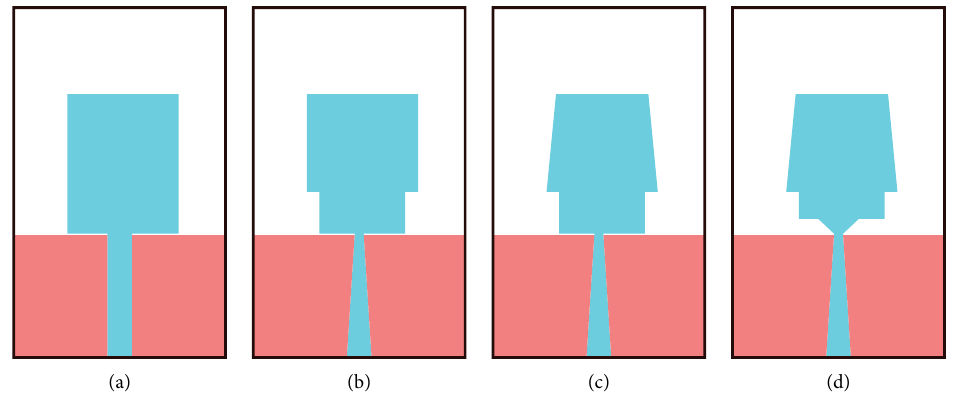
Figure 1: Evolution of the antenna unit. (a) Antenna 1. (b) Antenna 2. (c) Antenna 3. (d) Antenna 4.